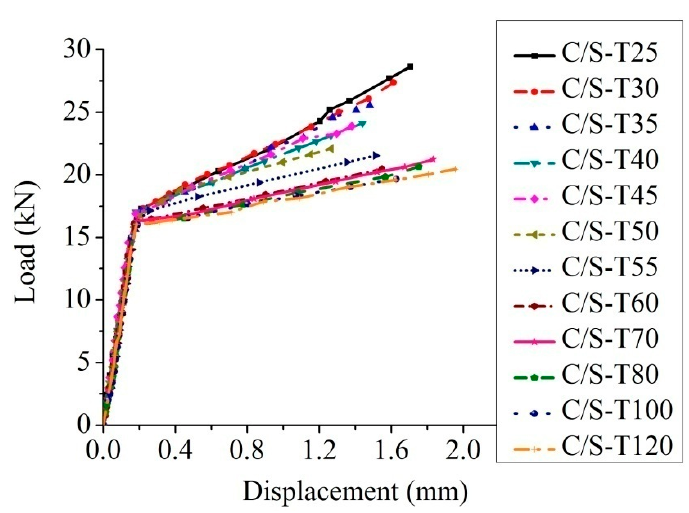
Figure 6. Load-displacement curves of series T specimens.